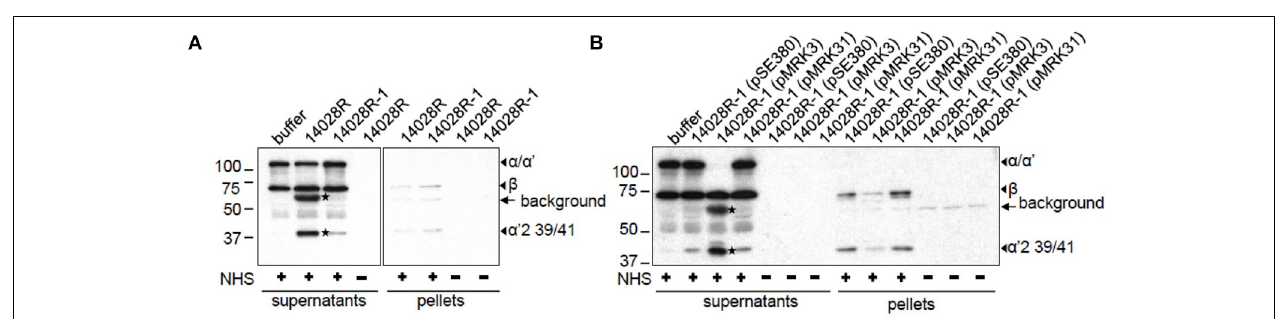
FIGURE 5 | C3 inactivation by S. enterica in serum. (A) S. enterica 14028R and 14028R-1 or (B) 14028R-1 strains complemented with PgtE (pMRK3), PgtE D206A (pMRK31) or empty vector (pSE380), were incubated in 5% NHS-VBS or in plain VBS for 1h and pelleted. The